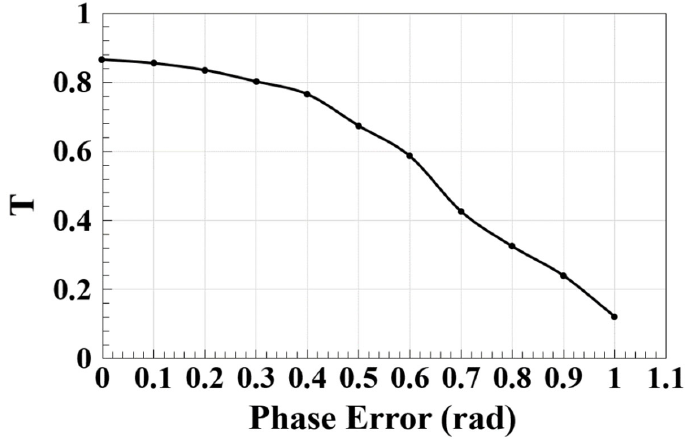
Figure 4. Spectral transmission (T) versus phase error utilizing 2 × 2 silicon waveguide at 1.55 μ m. The top and lower waveguide arms are separated by a gap of 4 μ m. This gap plays a